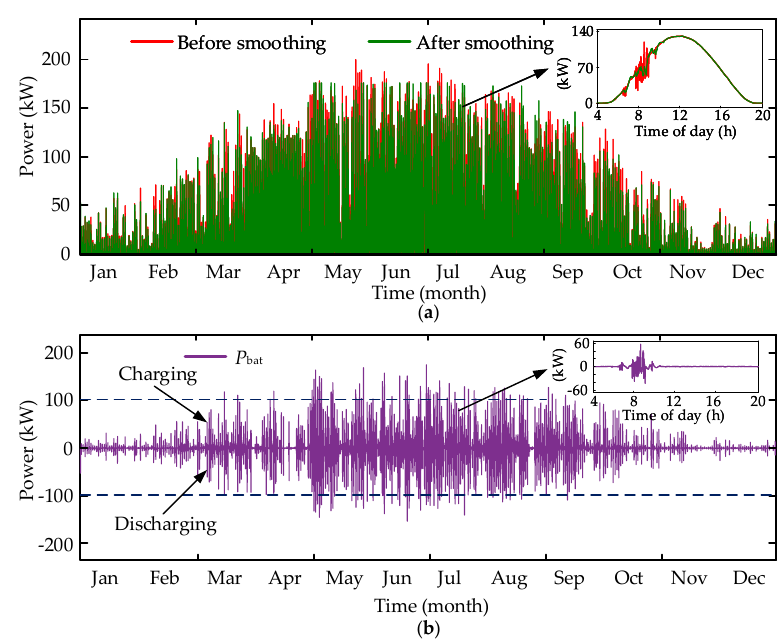
Figure 5. Power smoothing analysis: ( a ) input power of the PV inverter with and without power smoothing and ( b ) power reference for the DC-coupled BESS.